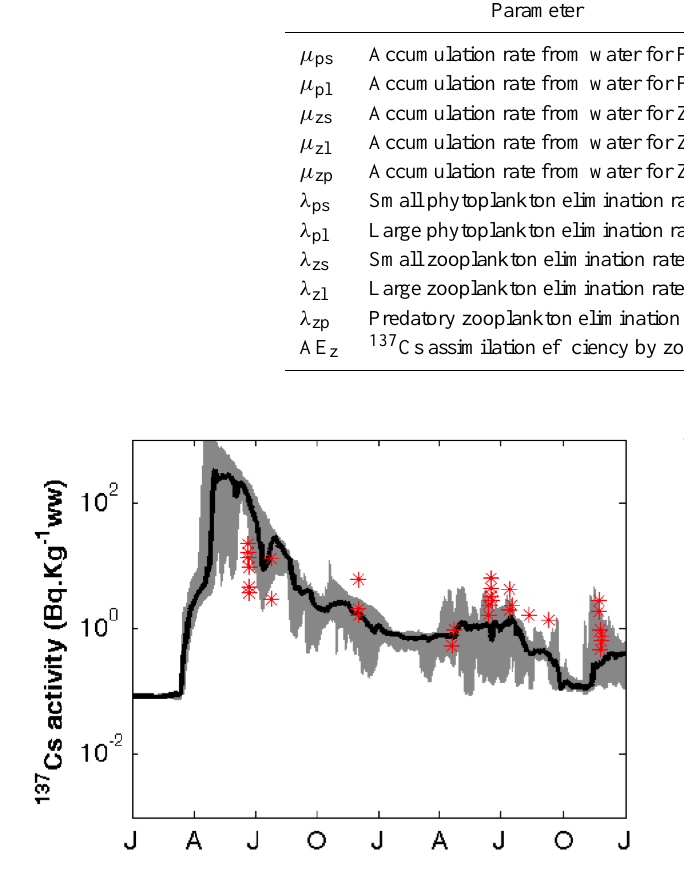
Figure 3. Results of the model calibration represented as the spatial median of the weighted average of 137 Cs concentration in the three zooplankton groups situated in Sendai Bay. The red stars represent the field data of 137 Cs activity in zooplankton in the same location (Kaeriyama et al.,